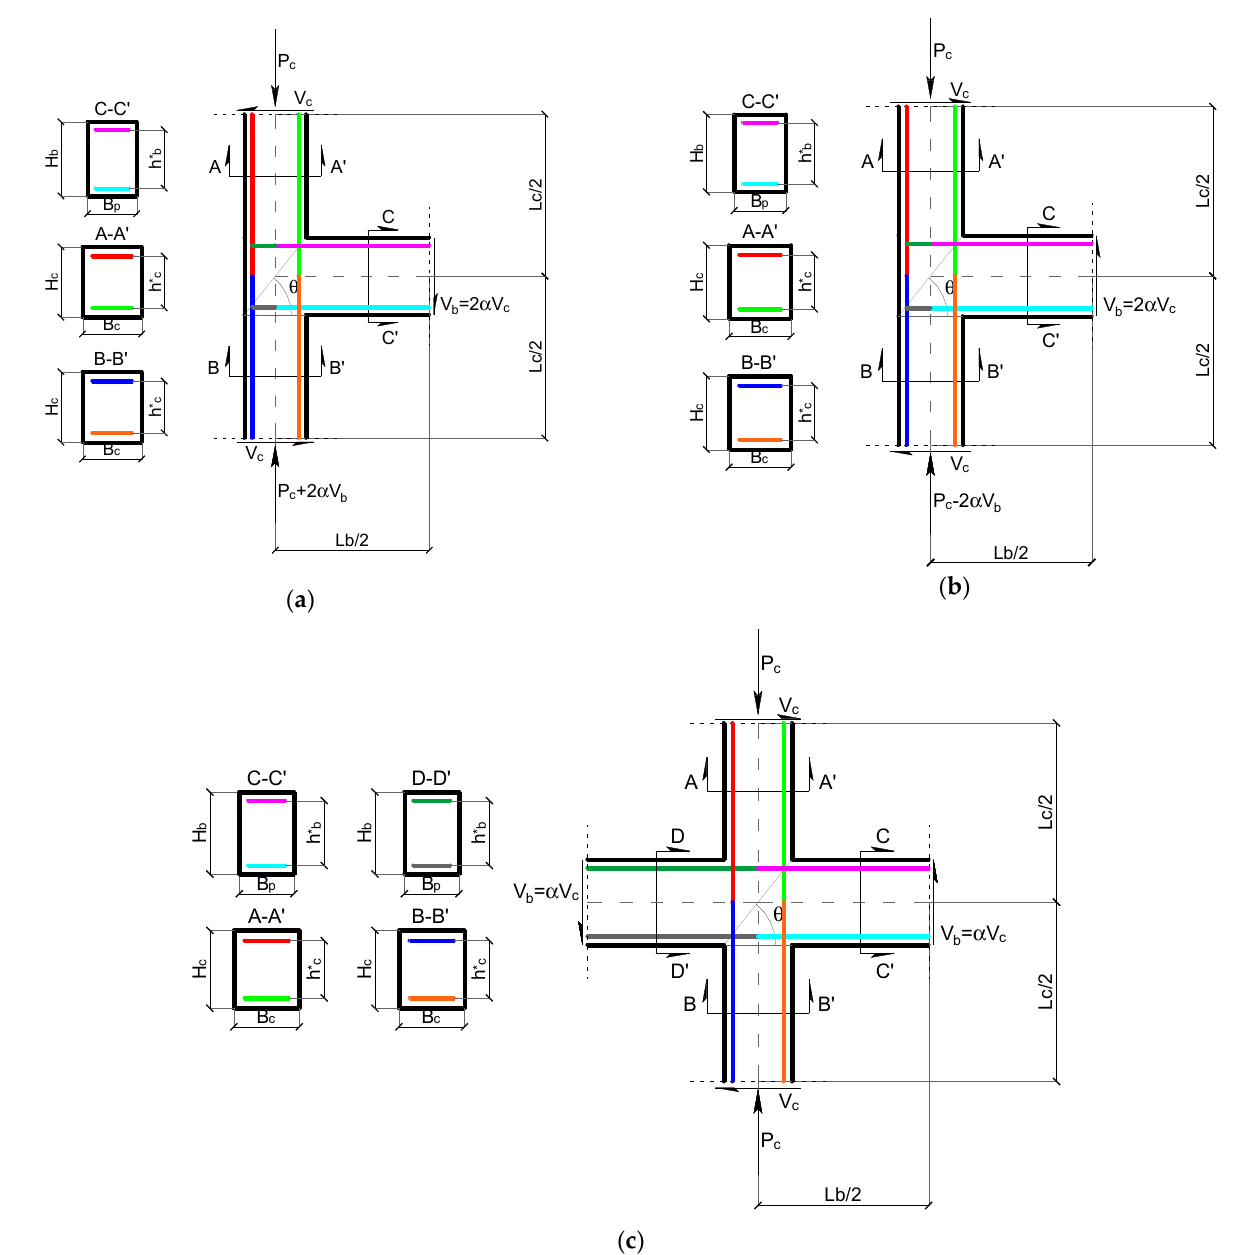
Figure 1. Characteristics and external forces acting on the RC joints: ( a ) positive direction of the column shear acting on the T-shaped RC joint, ( b ) negative direction of the column shear acting on the T-shaped RC joint, and ( c ) positive direction of the column shear acting on the X-shaped RC joint (negative is symmetrical).